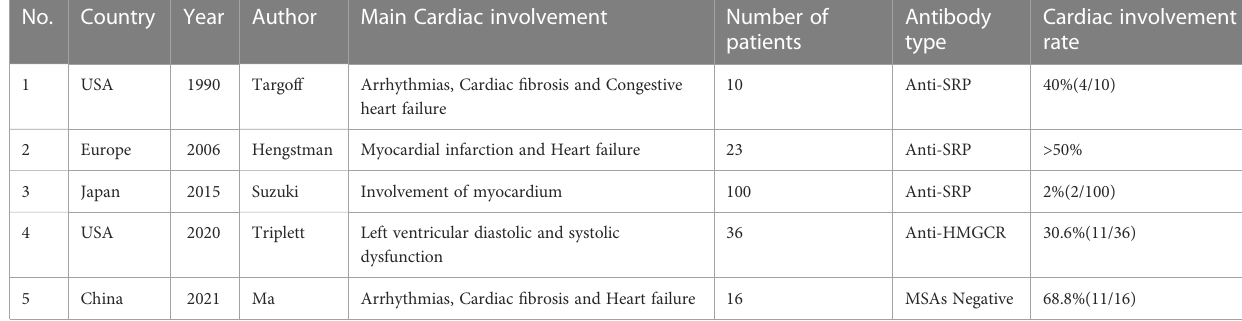
TABLE 2 Results from previous literature